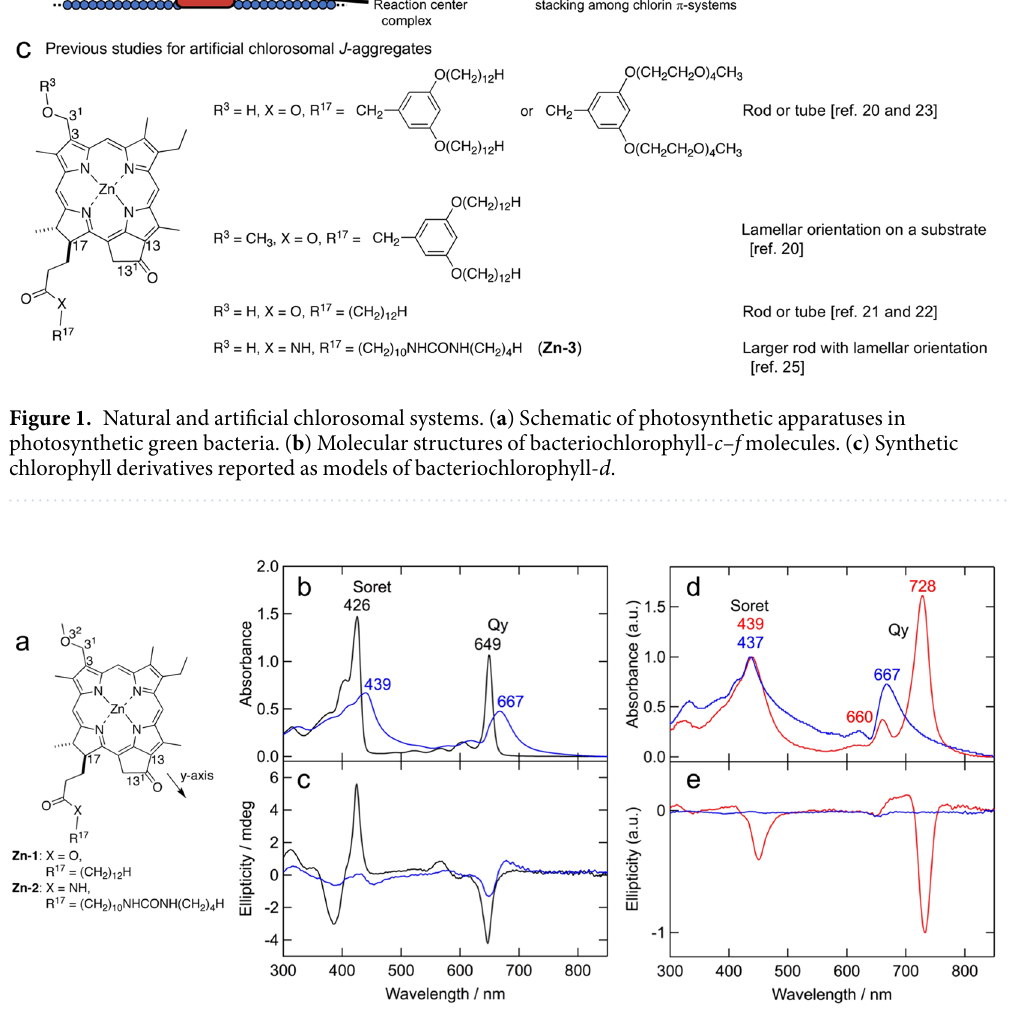
Figure 2. Supramolecular assembly of zinc 3 1 -methoxy-chlorophyll derivatives. ( a ) Molecular structures of Zn- 1 and Zn-2 . ( b ) UV-Vis-NIR absorption and ( c ) CD spectra of Zn-2 (10 μ M) in THF (black), and THF/hexane (1:99, vol/vol) (blue). ( d ) UV-Vis-NIR absorption and ( e ) CD spectra of Zn-2 solids prepared from THF/hexane (5:95, vol/vol) (100 μ M) just after preparation (blue) and after standing in solution for 1 week